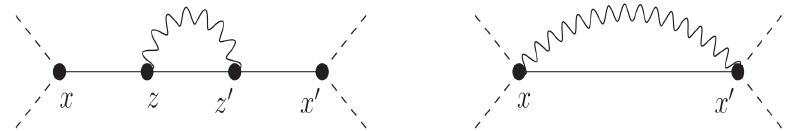
Figure 1 . The left diagram shows how the self-mass (1.3) contributes to massive scalar scattering. The diagram on the right gives the contribution from graviton correlations between the vertices. Solid lines represent the massless scalar, wavy lines represent the graviton, and dashed lines are massive